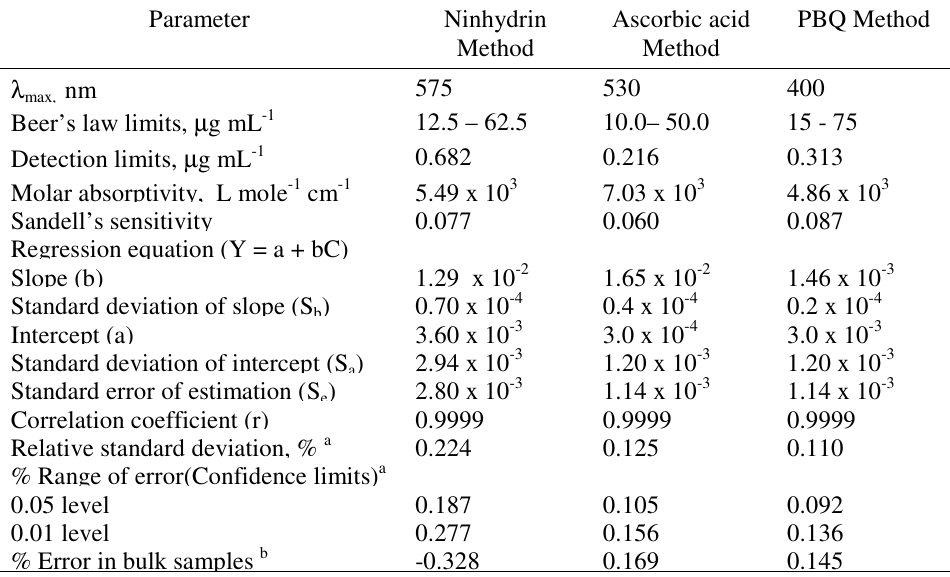
Table 1. Optical and Regression Characteristics, Precision and Accuracy of the Proposed